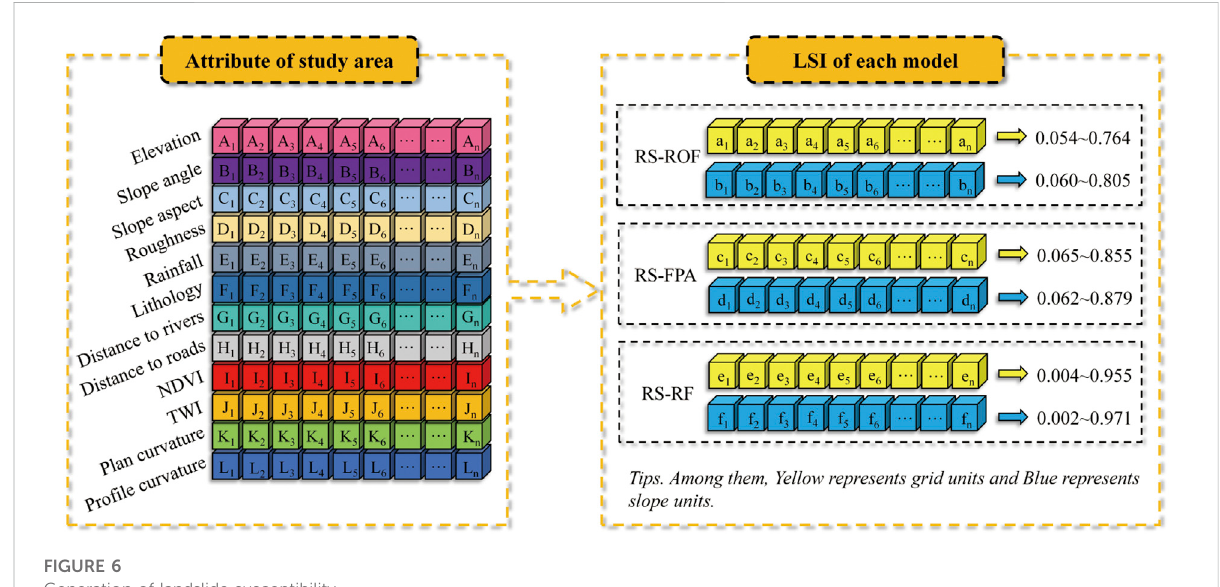
FIGURE 6 Generation of landslide